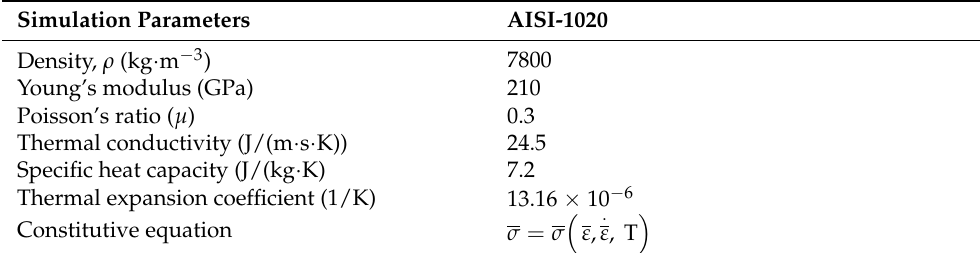
Table 1. Mechanical and thermal properties of disk workpieces.